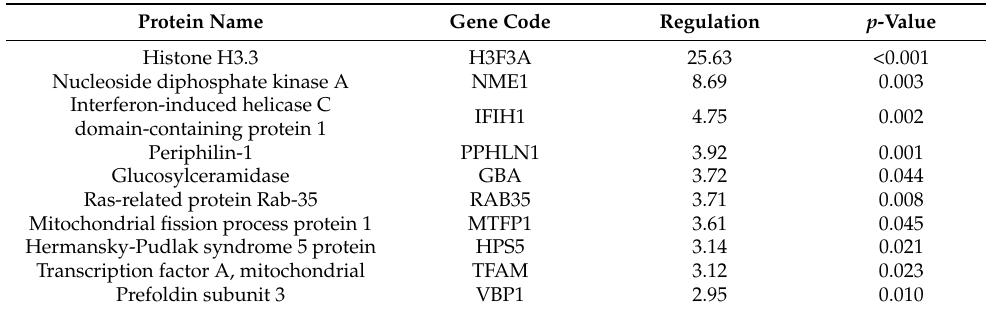
Figure 4. Differences in protein abundance in LCL721.221/sHLA-B*57:01 cells compared to parental LCL721.221 cells following ABC treatment. The volcano plot illustrates significantly differentially abundant proteins after ABC treatment of three technically independent replicates ( n = 3). The log 2 -fold change of LCL721.221/sHLA-B*57:01 cells compared to parental LCL721.221 cells is plotted against the –log 10 p -value. Proteins were regarded as regulated in LCL721.221/sHLA-B*57:01 cells from factor ± 1.0 and p < 0.05. Downregulated proteins are labelled in green; unregulated proteins are colored in grey and upregulated proteins are given in red. Table 2. Strongest upregulated proteins in LCL721.221/sHLA-B*57:01 cells compared to parental LCL721.221 cells after ABC